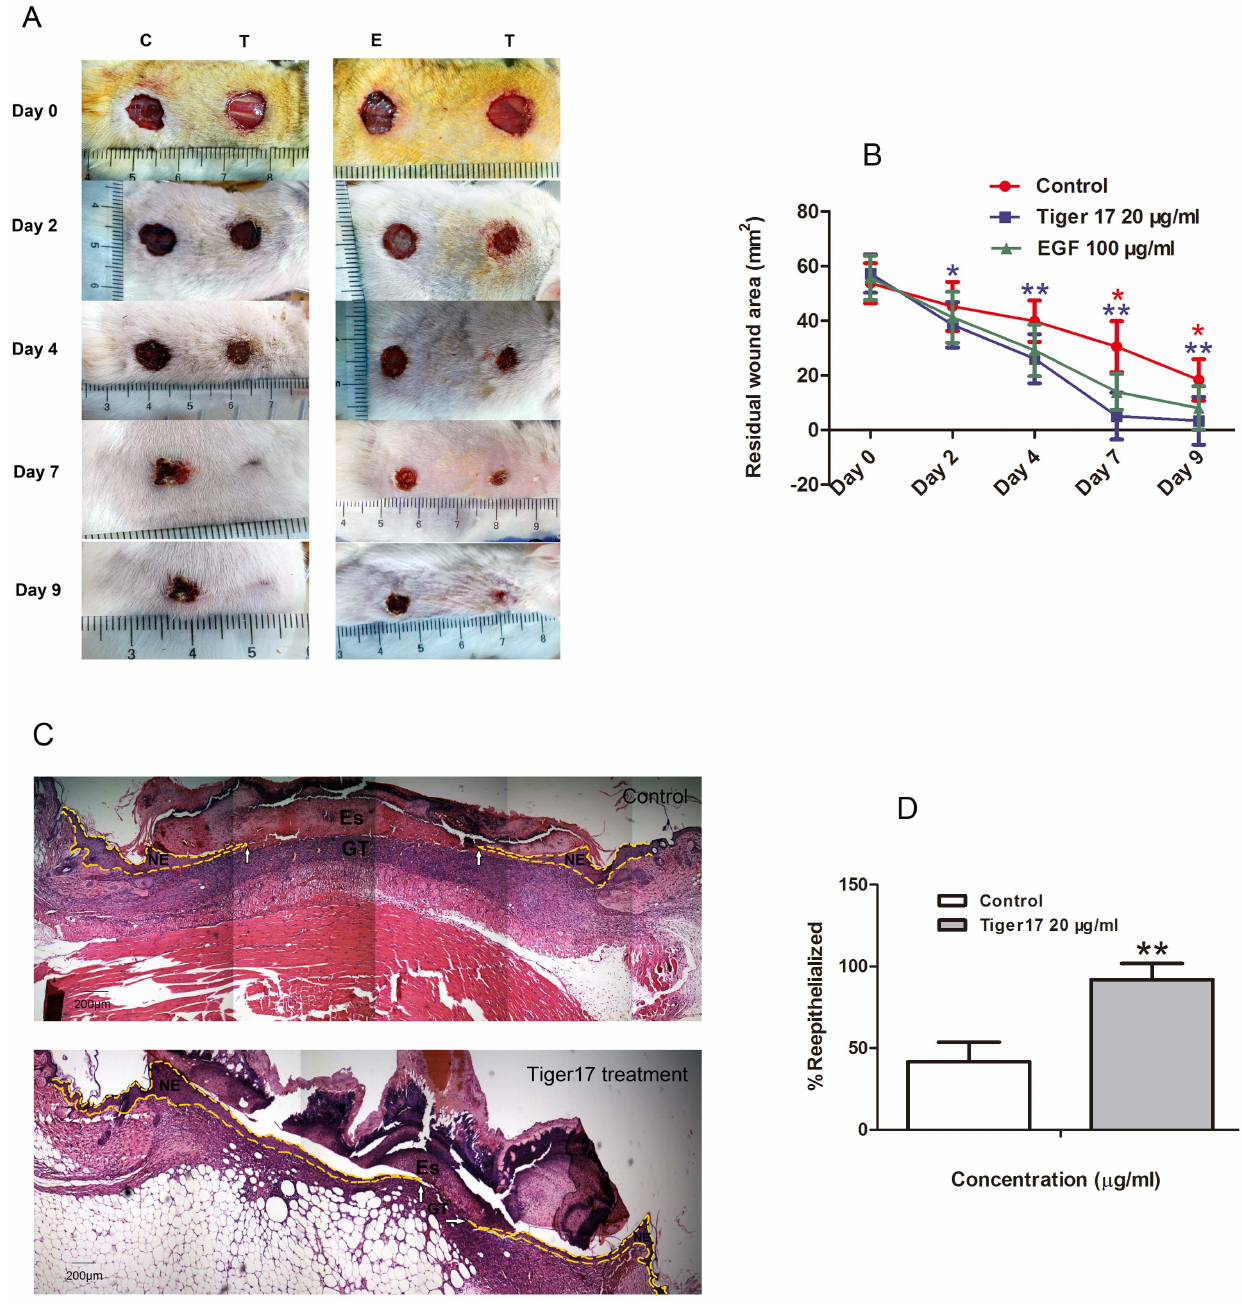
Figure 2. Topical application of tiger17 accelerated healing of full-thickness skin wounds in mice. Two full-thickness wounds were made on the back of a mouse. Mice bearing wound were randomly divided into two groups, T group and E group, 10 mice each. T group was separately provided 20 m l of tiger17 (20 m g/ml) or vehicle; and E group was respectively applied 20 m l of tiger17 (20 m g/ml) or 20 m l of EGF (100 m g/ml) solution. (A) Images of a representative mouse from each group taken on post-operative day 0, 2, 4, 7 and 9 were shown. (B) Evaluation of wound closure by morphometrical analysis of wound areas (Image J, NIH). Wound residual area was calculated (n=10) from three independent experiments. *P , 0.05; **P , 0.01 (red asterisk represented tiger 17 treatment vs EGF treatment, and blue asterisk represented tiger 17 treatment vs control). (C) Post- operative day 8, healing skin was examined by H&E staining sections. The gap between neo-epithelial tongue was much narrower in tiger17-treated group (white arrows pointed) than control (white arrows pointed); and neo-epithelial tongue, marked by yellow dotted line, was much longer in the same magnitude of enlargement in tiger17 treatment mice. NE: neo-epithelium; GT: granulation tissue; Es: eschar. (D) Reepithelialization rate. Wound reepithelialization rate was calculated from the H&E stain sections. Bars=mean 6 SEM. *P , 0.05; **P , 0.01 (tiger17 treatment vs control). Average and standard error of the mean were derived from three independent experiments and 6 different sections per experiment. doi:10.1371/journal.pone.0092082.g002 treatment skin wound (Fig. 2A and C). Fibroblast-to-myofibroblast Myofibroblasts are activated fibroblasts, which have differentiated transition plays important role in cutaneous wound healing [18]. into a contractile phenotype and were characterized by the